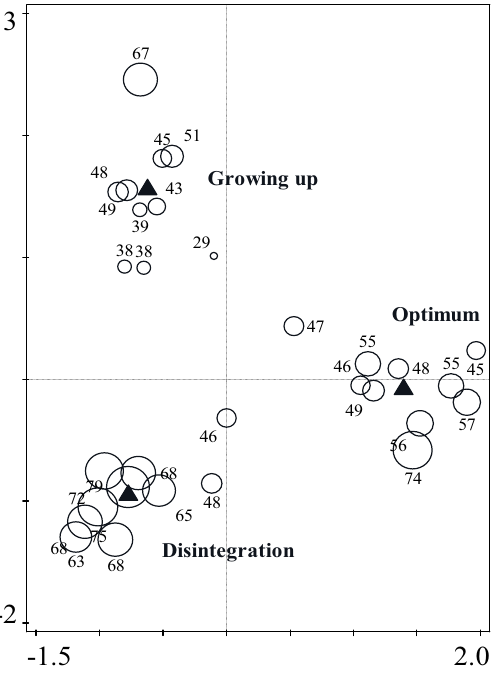
Figure 9. Diagram of sample by development stage of beech stands, which the size of each circle indicates the species richness of the samples (absolute number of species in the trap) CCA (pF = 1.3; p = < 0.001).